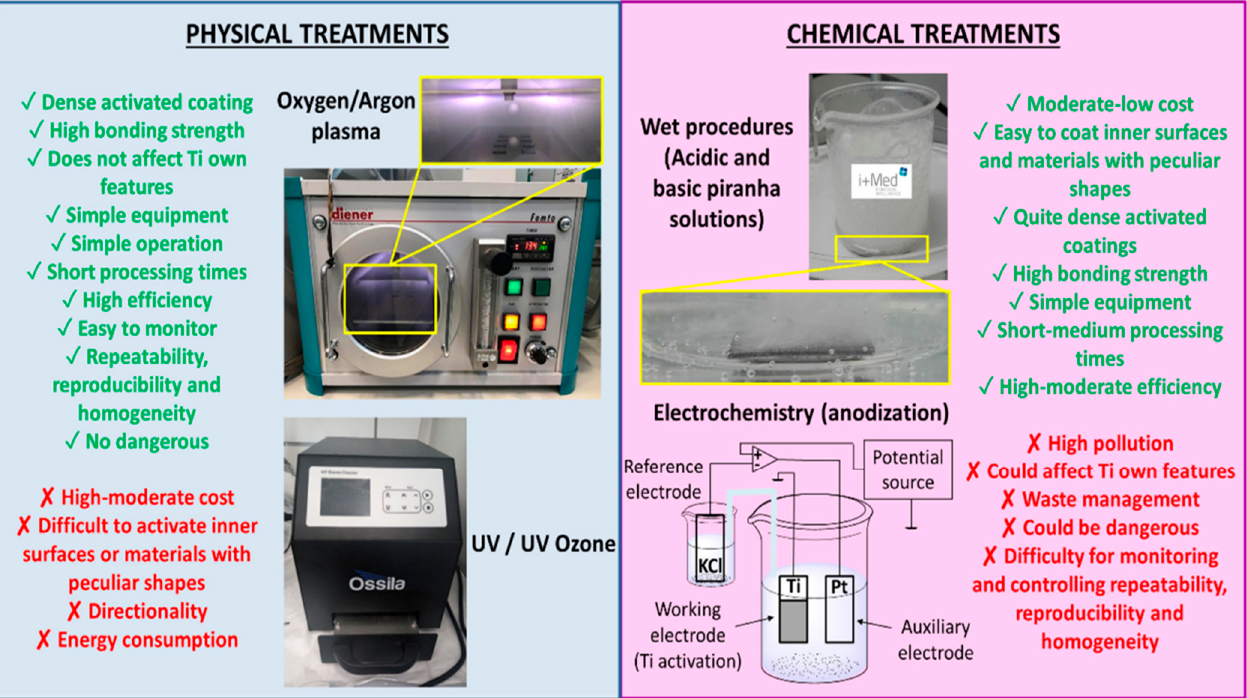
Figure 28. Several physical and chemical treatments for the surface modifications of biomedical metals such as Ti surface along with their advantages ( green ) and disadvantages ( red ). Reprinted with permission from [43]. Copyright 2021 MDPI. Distributed under Creative Commons Attribution-based license (CCBY 4.0.).